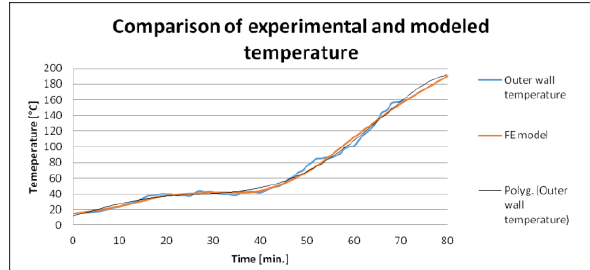
Fig. 5. FE model with modified material parameters A graphical representation of results is put in Fig. 6- 13. They show time course of temperatures each ten minutes from 0 to 70 min.